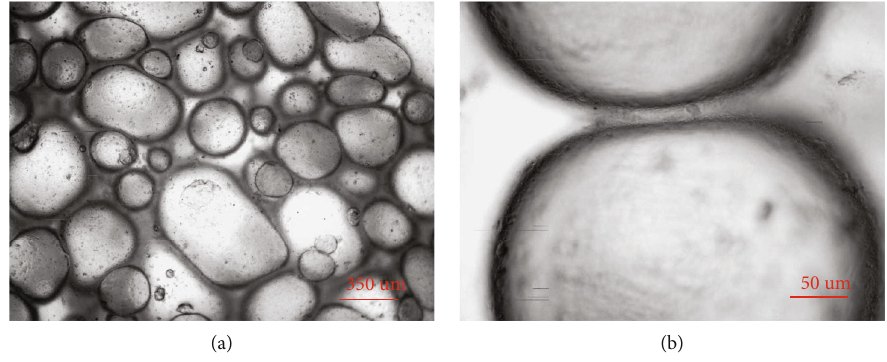
Figure 12: Optical microstructure of the paste material.